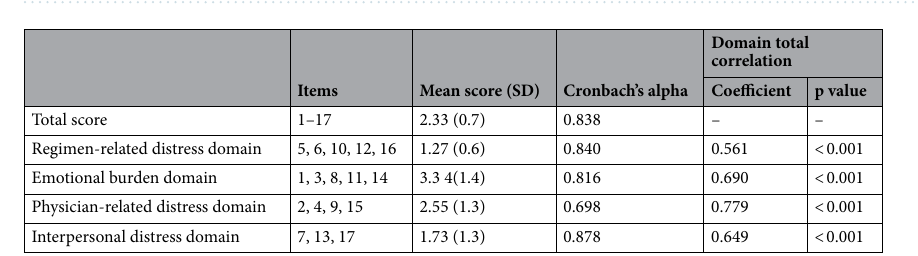
Figure 1. Component loading plot depicting extraction of 4 domains of BDDS-17 [emotional burden (EB), regimen-related distress (RR), physician-related distress (PR), interpersonal distress (IP)]. Items presented in vertical axis and are clustered according to the components (domains), Loading strengths are plotted at the horizontal axis. *Loading gradient high = blue, mid = "white", low = "red", midpoint = 0.